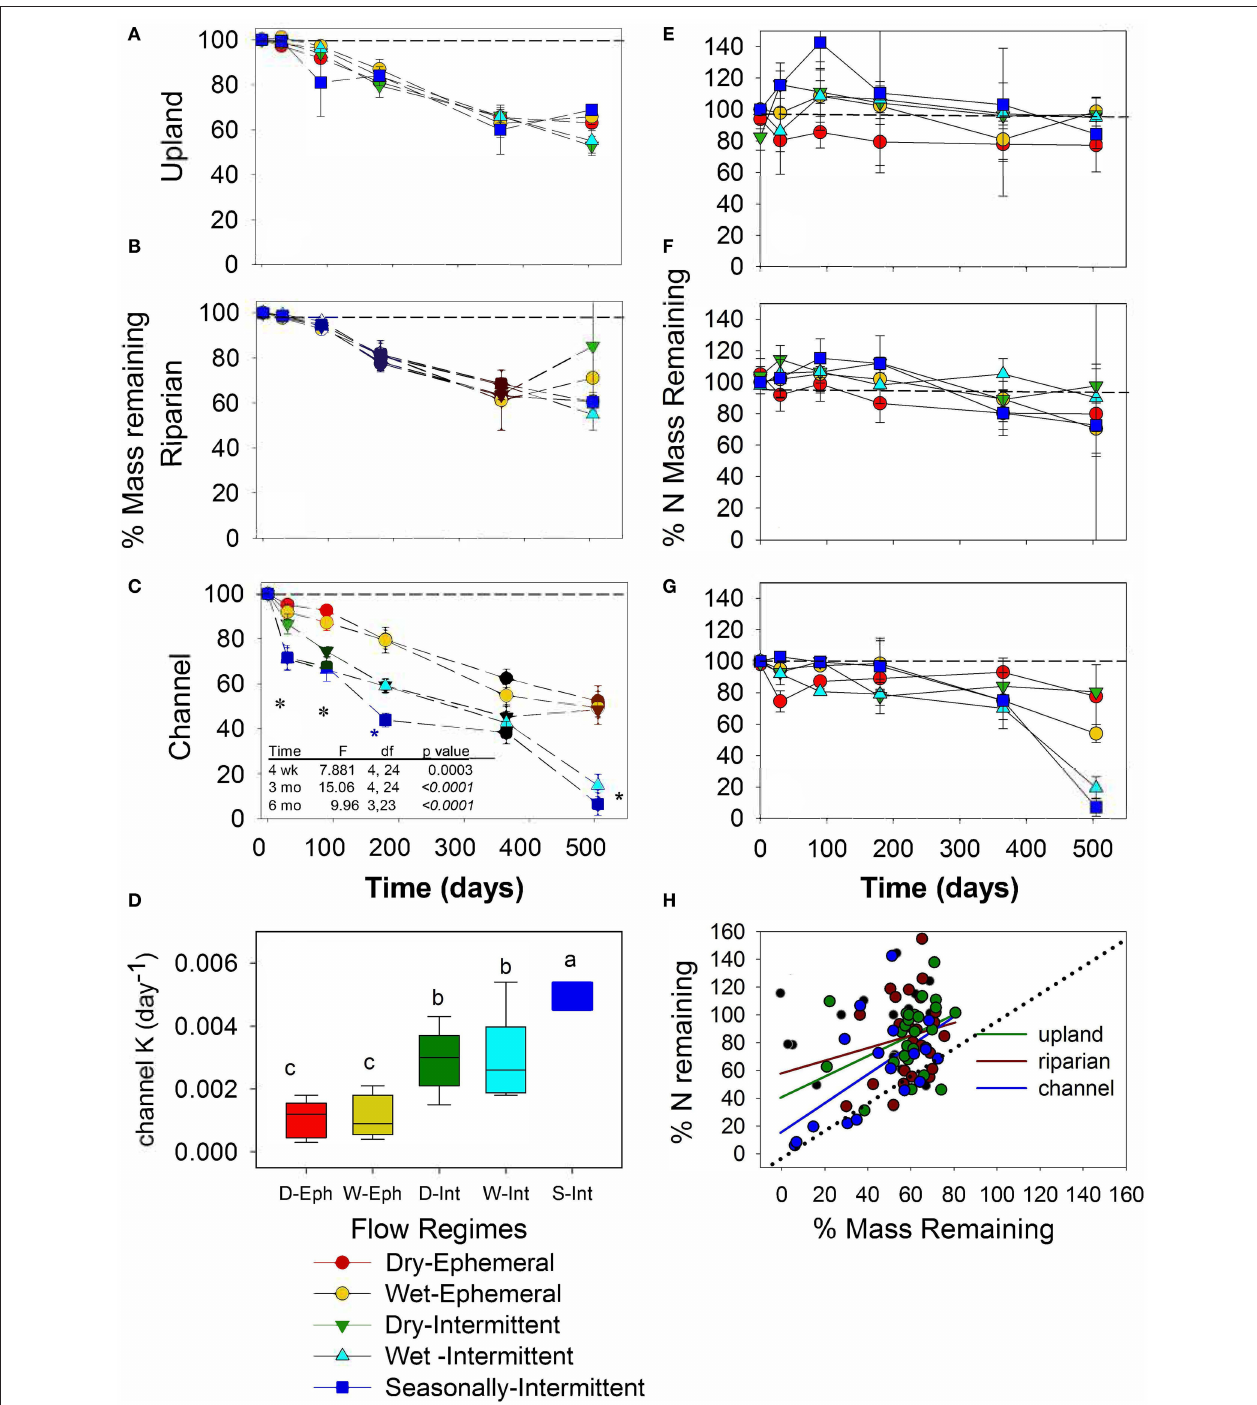
FIGURE 4 | Mass remaining as percent (%) of initial oak litter mass over time (days since deployment) for 10 study sites in the (A) upland, (B) riparian and (C) channel positions, and (D) oak leaf decay ( k ) rates shown for the channel position by flow regime (D-Eph, Dry-ephemeral; W-Eph, Wet-Ephemeral; D-Int, Dry-intermittent; W-Int, Wet-Intermittent; and S-Int, Seasonally-Intermittent). Asterisks in (C) indicate significant differences in mass loss among sites at different time points as tested with ANOVA and post-hoc Tukey tests ( p < 0.05). Different letters in (D) indicate significant differences in decay rate among flow regimes ( p < 0.05). Mass is expressed in ash free dry mass. Percent N mass remaining of initial oak litter N over time (day since deployment) for the different flow regimes in the (E) upland, (F) riparian, and (G) channel positions. (H) Relationship between %N remaining and % mass remaining shows that upland and riparian locations showed net gain while N loss in channel positions was proportional to mass